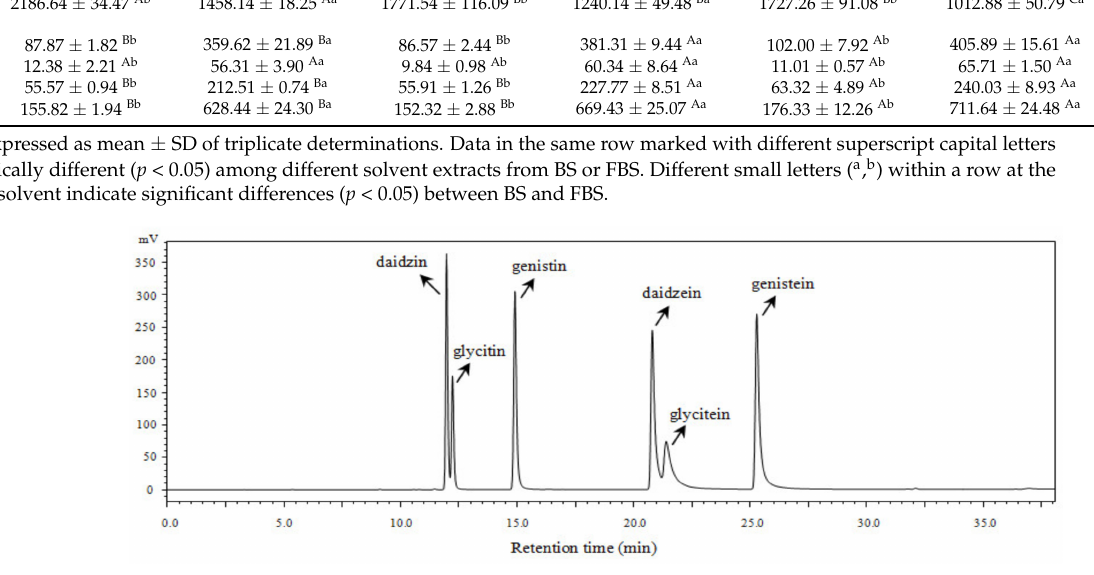
Figure 2. High-performance liquid chromatographic (HPLC) chromatogram of the major six